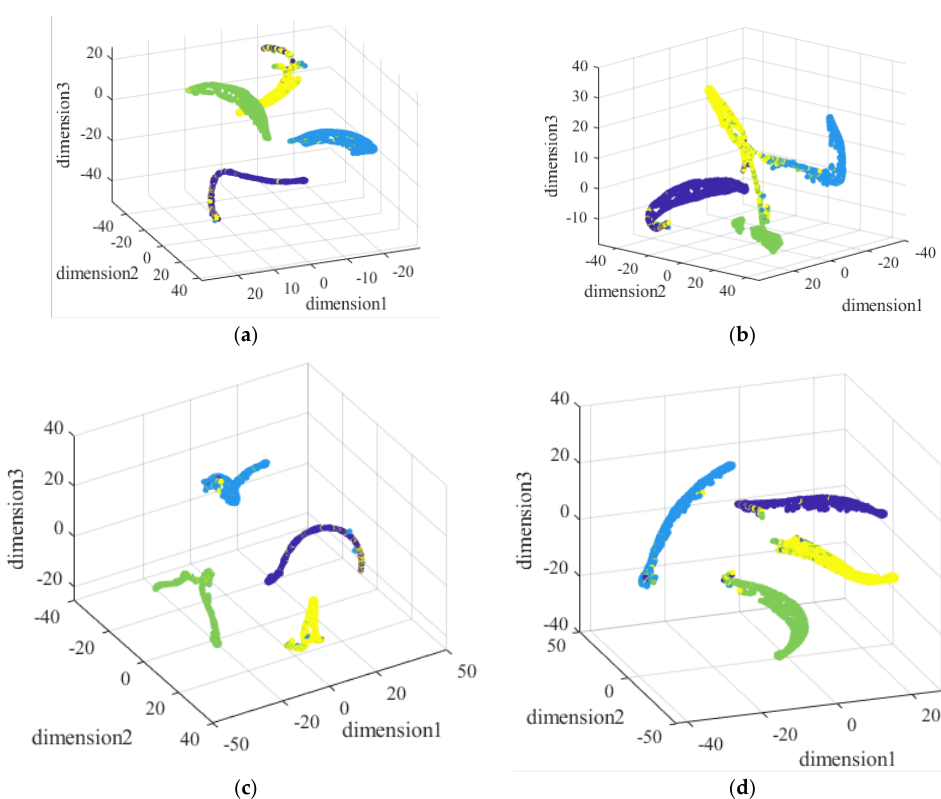
Figure 19. Accuracy comparisons with different datasets. ( a ) Original samples. ( b ) Including generated samples by GAN. ( c ) Including generated samples by DCGAN. ( d ) Including generated samples by Improved DCGAN.